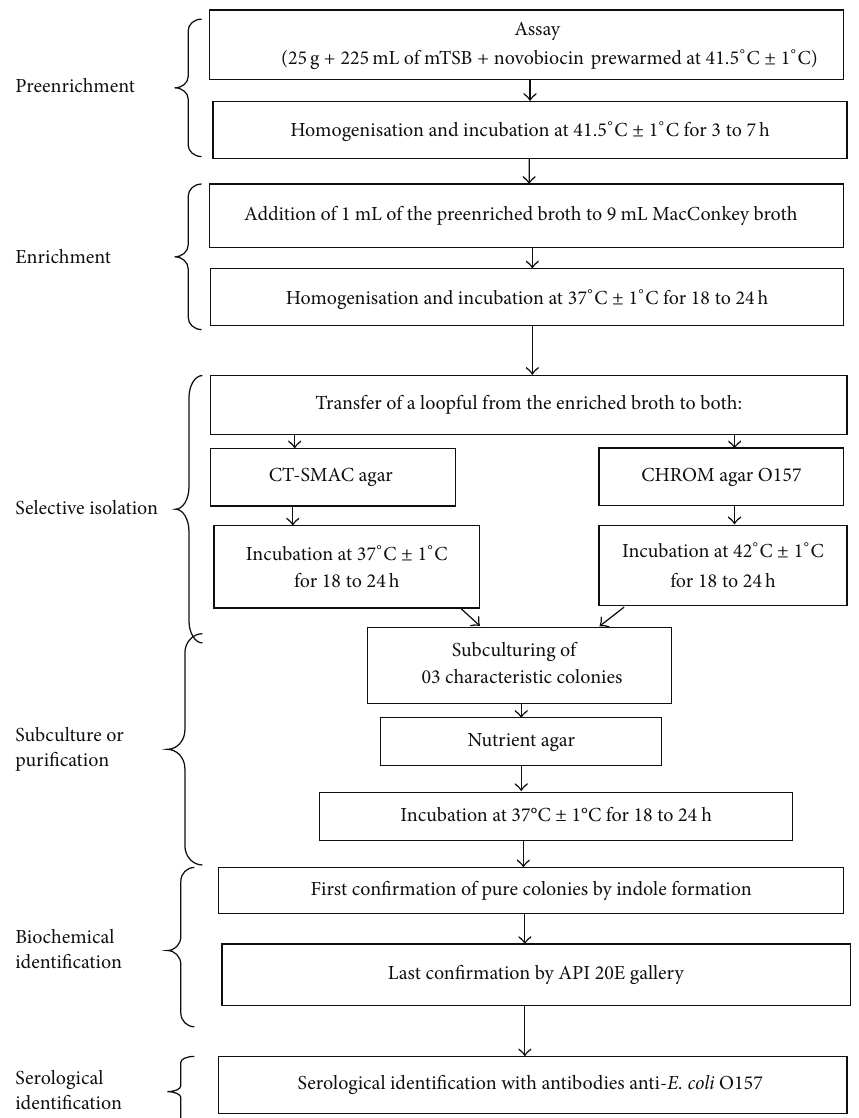
Figure 1: Method of treatment of the